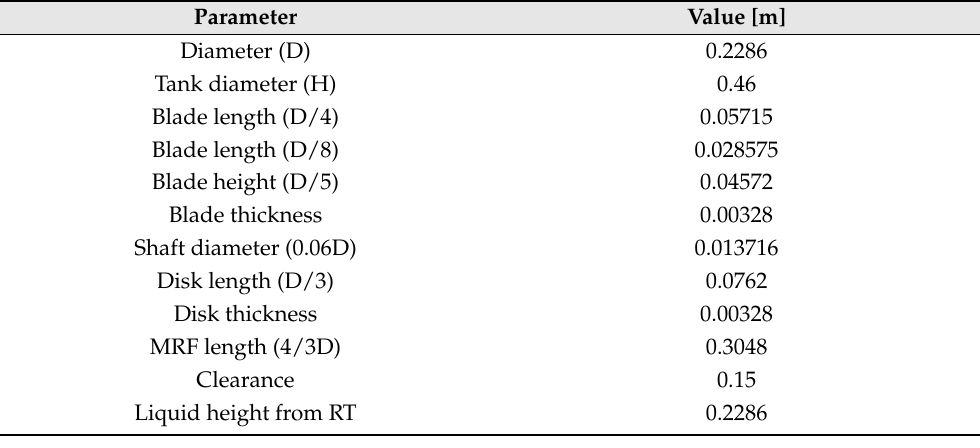
Table 1. Geometrical details of the CFD model of the simple agitation device.